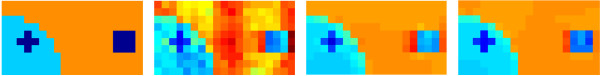
3X zoom of a region in the 3rd layer.From left to right: Original image, reconstructed images by ART, ART+TV, (ART + TV)NLM.